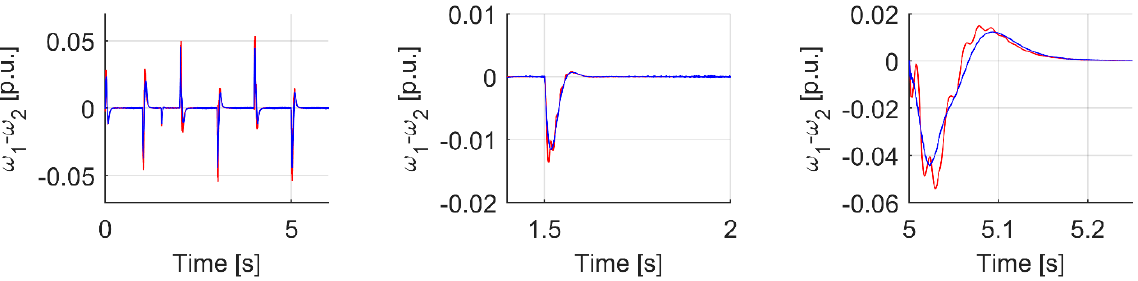
Energies 2022 , 15 , x FOR PEER REVIEW 19 of 24